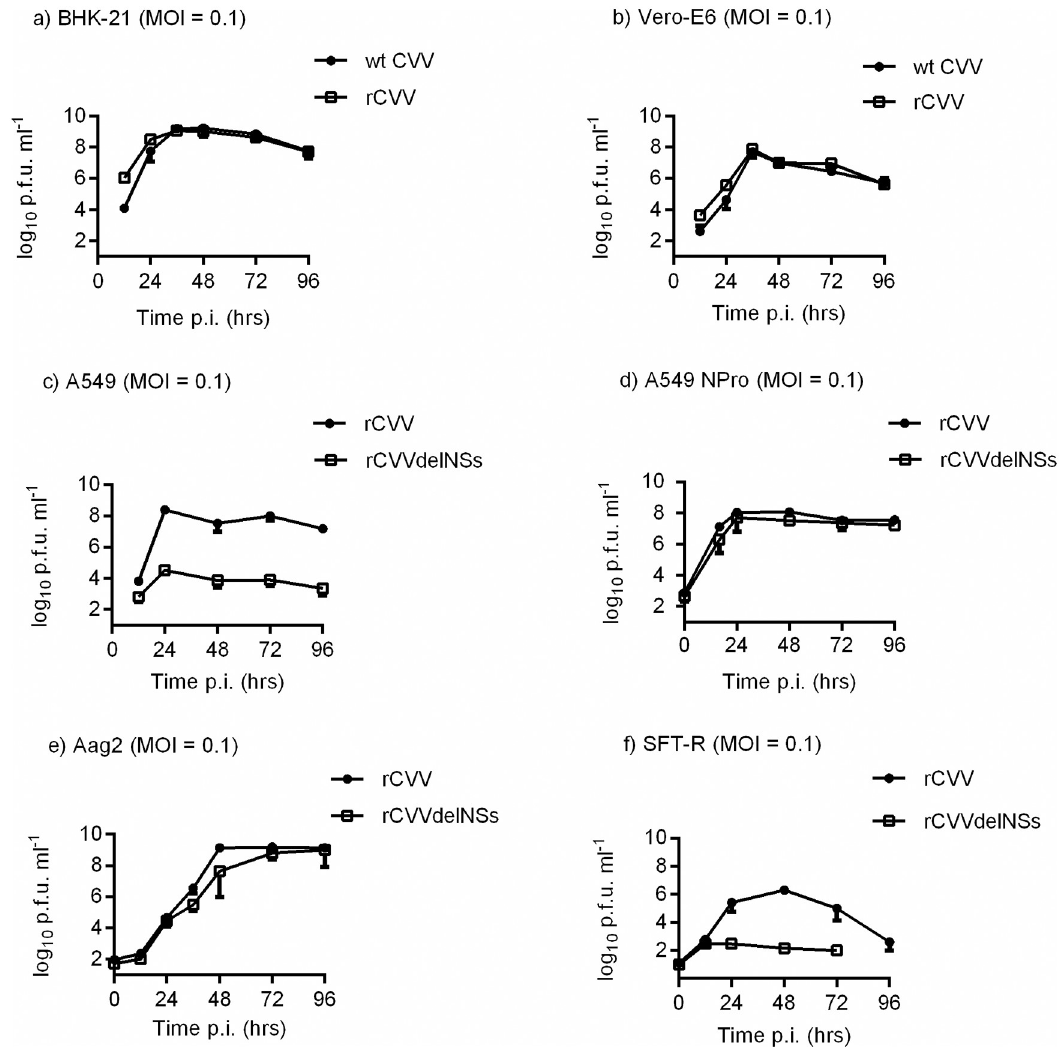
Fig 3. CVV growth in cell culture. Cell lines BHK-21 (a) , Vero-E6 (b) , A549 (c) , A549 NPro (d) , Aag2 (e) and SFT-R (f) were infected at a MOI of 0.1. The curves show the titre of CVV accumulated at 12 or 24 hr intervals. The titre of the virus at each time point was determined by plaque assay; virus titres are indicated in plaque forming units per ml (PFU/ml). Representative experiments are shown (n = 2). Error bars indicate standard deviation